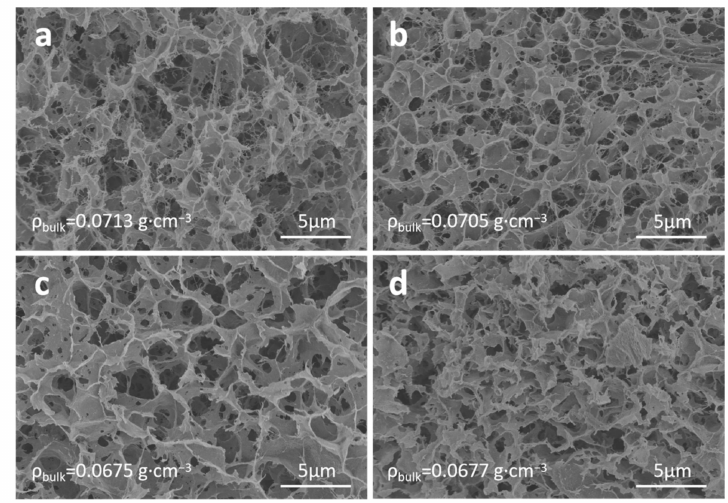
Figure 3. SEM images of cellulose aerogels prepared in NaOH/urea solution after different aging times: ( a ) 4 h, ( b ) 12 h, ( c ) 24 h, and ( d ) 48 h.